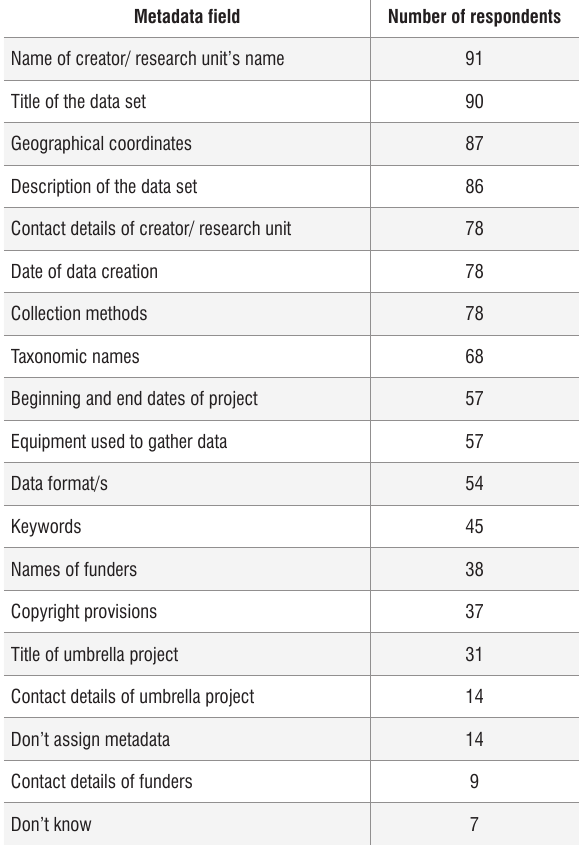
Types of metadata considered important to describe research data as reported by